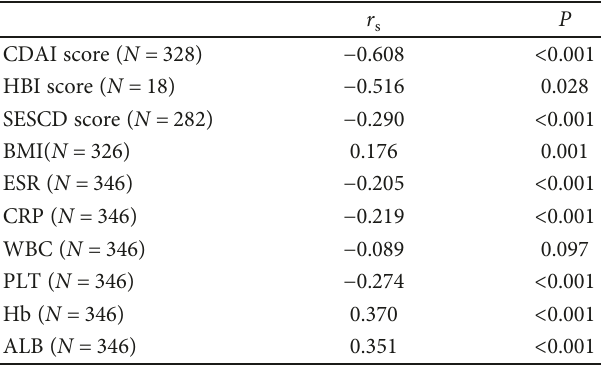
r ffi cient for Spearman correlation; CDAI, Crohn ’ s Disease s , correlation coe Activity Index; BMI, body mass index; SESCD, Simpli fi ed Endoscopic Score for Crohn ’ s Disease; ESR, erythrocyte sedimentation rate; CRP, C- reactive protein; WBC, white blood cell count; PLT, platelet count; Hb, hemoglobin; ALB,